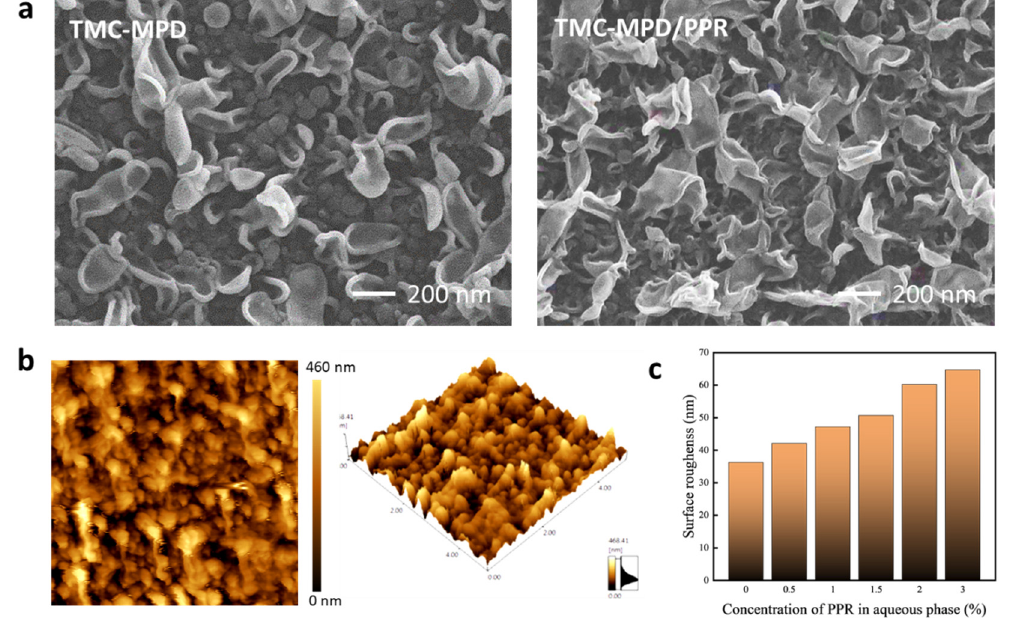
Figure 3. Structural properties of the fabricated RO membranes. ( a ) Surface SEM images of conven- tional RO membrane (TMC-MPD) and RFRO membrane (TMC-MPD/PPR; the concentration of PPR is 1.0%); ( b ) AFM height images of RFRO membrane; ( c ) variation of membrane surface roughness versus additional amount of PPR.